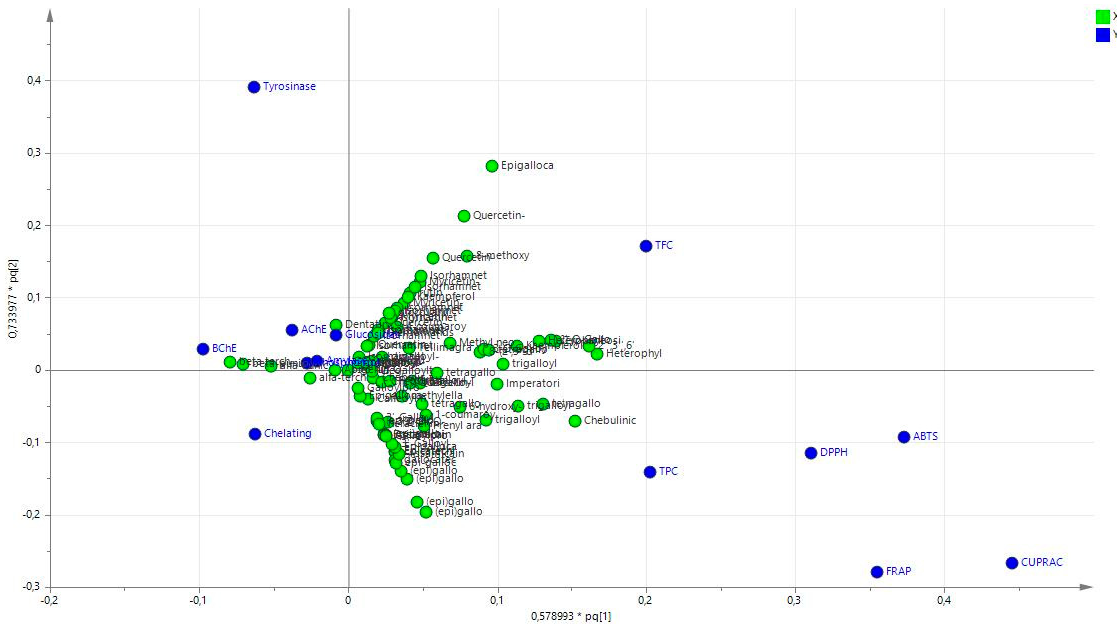
Figure 4. OPLS loading plot considering chemical components and biological properties.